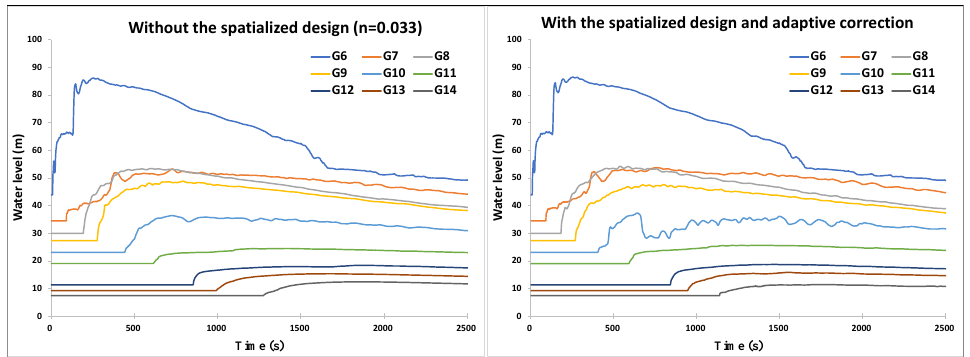
Figure 15. The water level curve of each gauge during the simulation. Table 2 shows the comparison of the maximum water level and the arrival time in the simulated model with the field-observed data in the physical model and results in the Telemac-2D model at the location of 9 gauges. For each gauge, the maximum water levels and arrival time of the flows in the physical model and the maximum water levels in the Telemac-2D simulation can be obtained from Hervouet’s thesis [31]. By comparing the average relative error, both the spatialized and non-spatialized models have similar simulation accuracy with the Telemac-2D simulation in terms of the maximum water level at each gauge. Comparing the relative errors, it can be seen that the spatialized design model has reduced the relative errors in the arrival time at each gauge compared to the non-spatialized design model. Additionally, the relative error in the water level does not change much for both. Figure 16 shows a comparison chart between before and after adaptive correction. As seen from the figure, with the adaptive correction of the Manning coefficients, the simulation results are more in line with the real situation. Table 2. Comparing the water arrival time and the max water